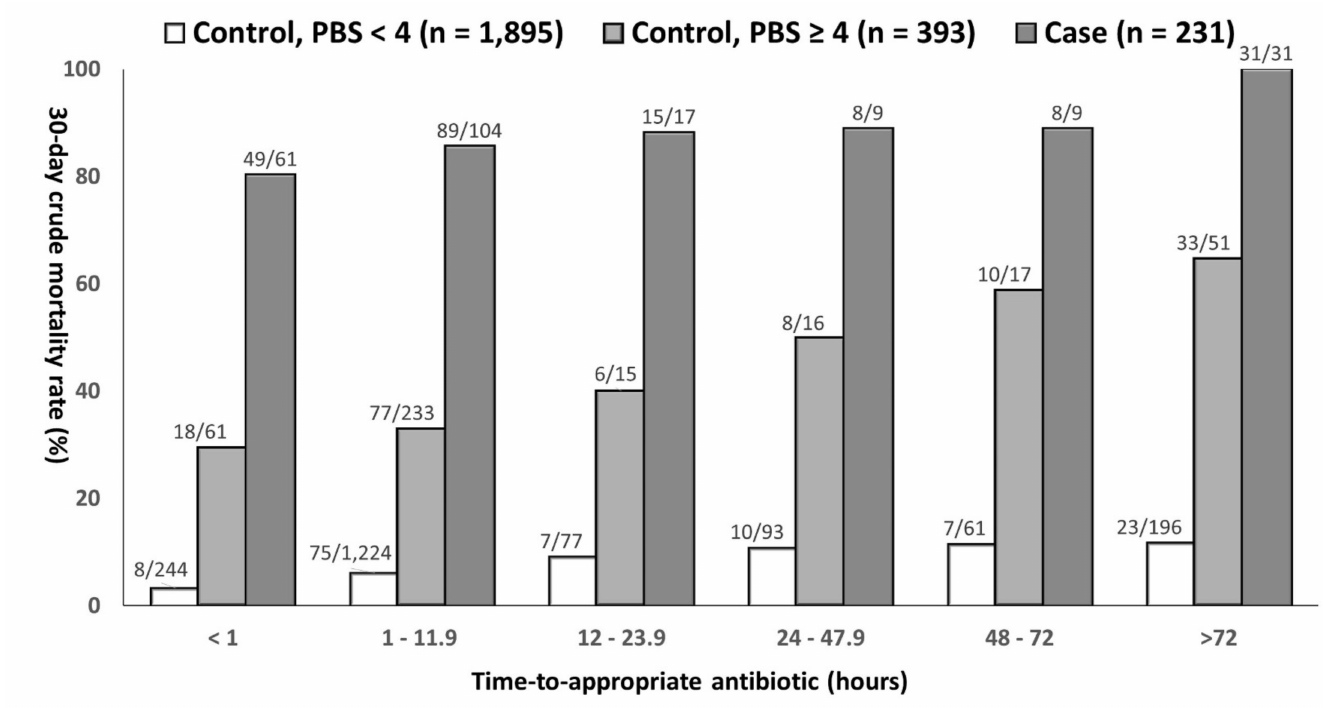
Figure 3. A positive trend of the time-to-appropriate antibiotic in the 30-day crude mortality rate in bacteremic patients, categorized into the case, critically ill (a Pitt bacteremia score ≥ 4) control, and less critical ill (a Pitt bacteremia score < 4) control patients. The denominators and numerators, respectively, indicate case numbers of crude 30-day mortality and all patients in varied categories of the time-to-appropriate